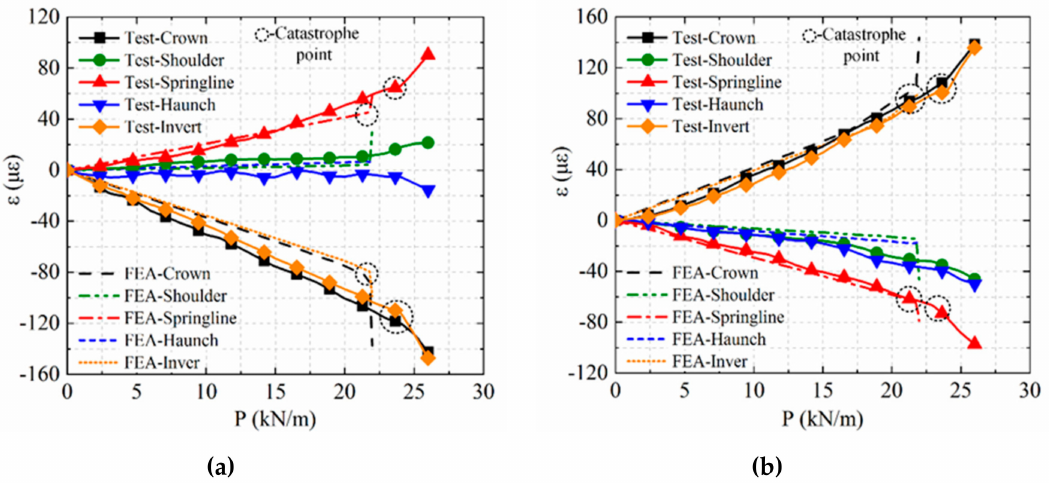
Figure 13. Comparison of load–strain curves of the intact pipe: ( a ) outer wall and ( b ) inner